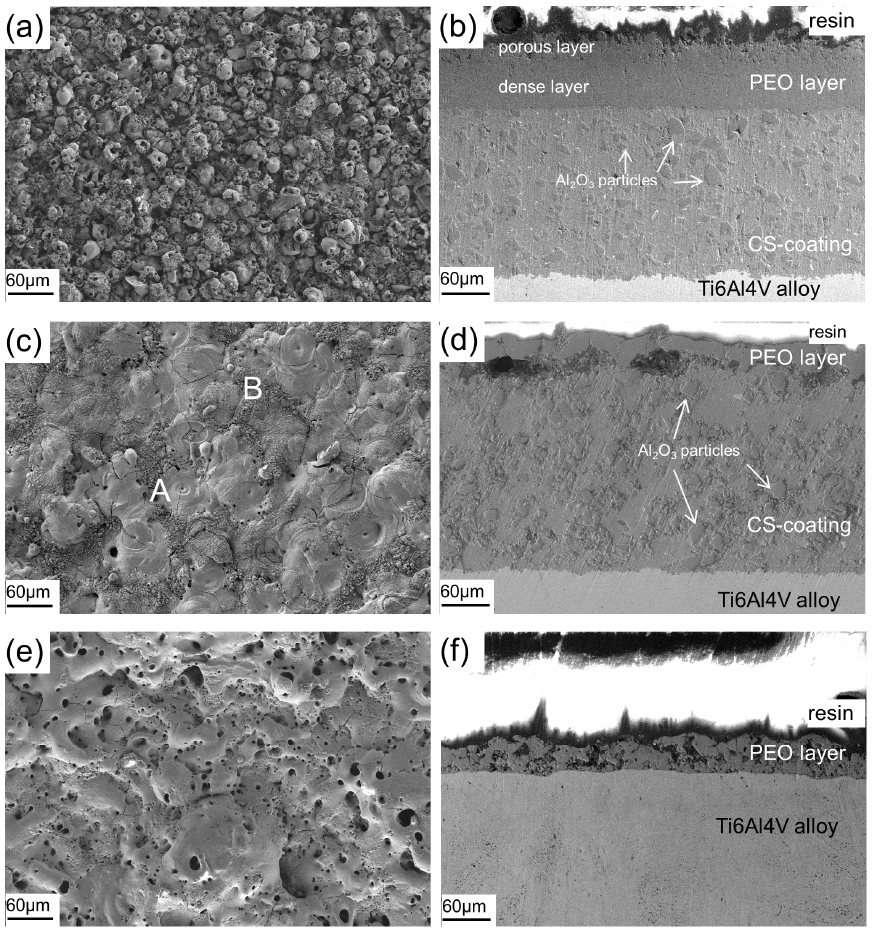
Figure 4. Surface morphologies of PEO coatings on samples: ( a ) S1; ( c ) S2; ( e ) S3; cross-section morphologies of samples: ( b ) S1; ( d ) S2; ( f ) S3.